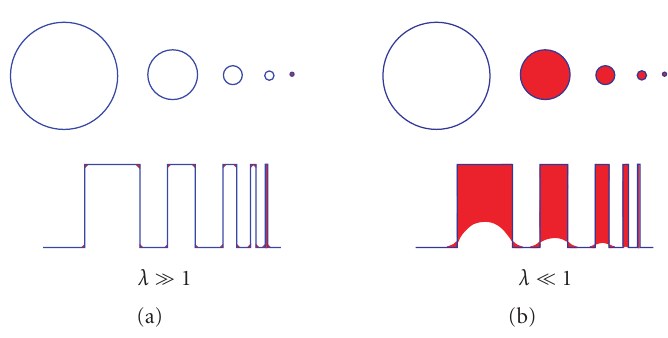
Figure 3.1. Flat norm with scale decompositions as a function of λ : the larger λ is, the less smoothing there is. Let T denote the blue input 1-currents and S denote the red optimal 2-currents. Then in fact, λ is the bound on the curvature allowed in T − ∂S , see [3, 2] for details. Accordingly, the curves T − ∂S are allowed greater curvature in the curves on the left than is permitted in those on the right.